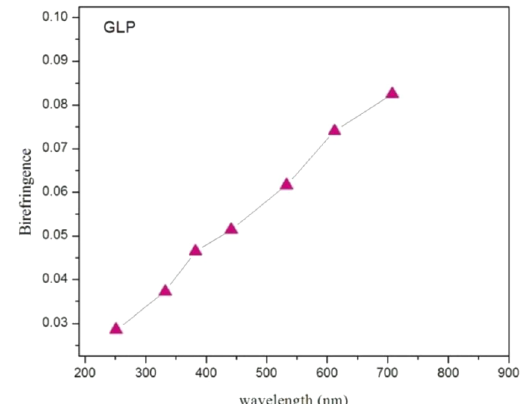
Figure 2. Plot of Birefringence verses